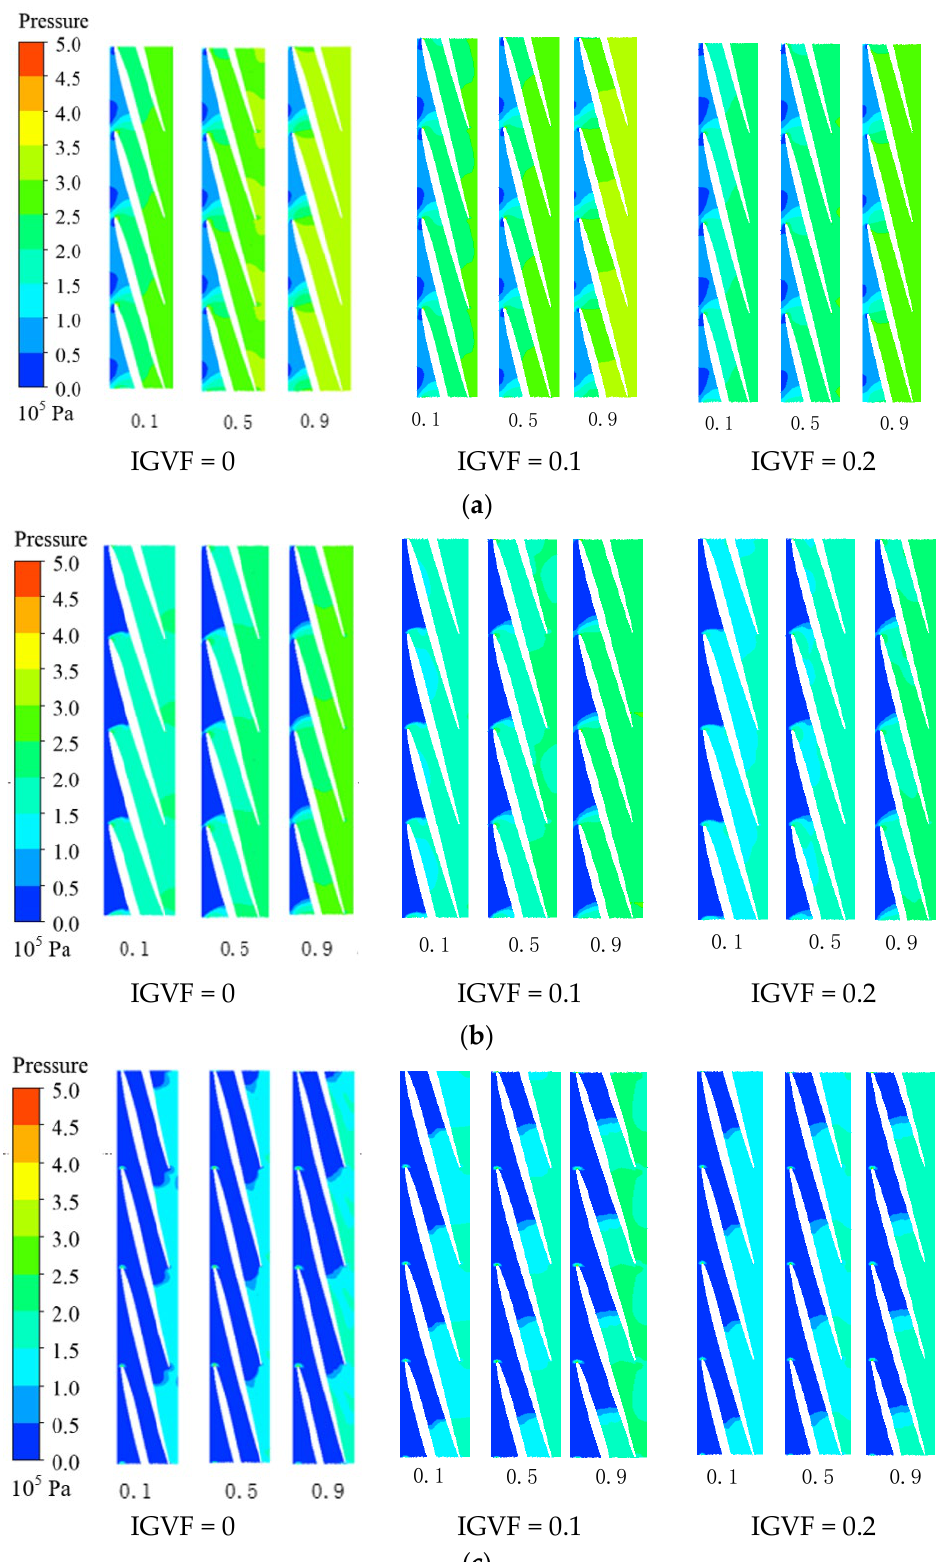
Figure 7. Pressure in impeller flow passage at IGVF = 0, 0.1, 0.2. ( a ) Critical cavitation; ( b ) severe cavitation; ( c ) fracture cavitation.